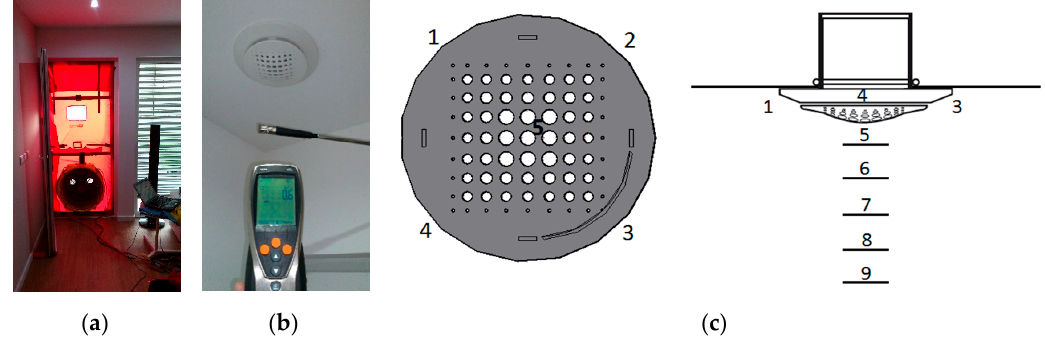
Figure 10. Experimental ventilation campaign: ( a ) blower door test setup; ( b ) air velocity measured with the anemometer probe; ( c ) measuring points.